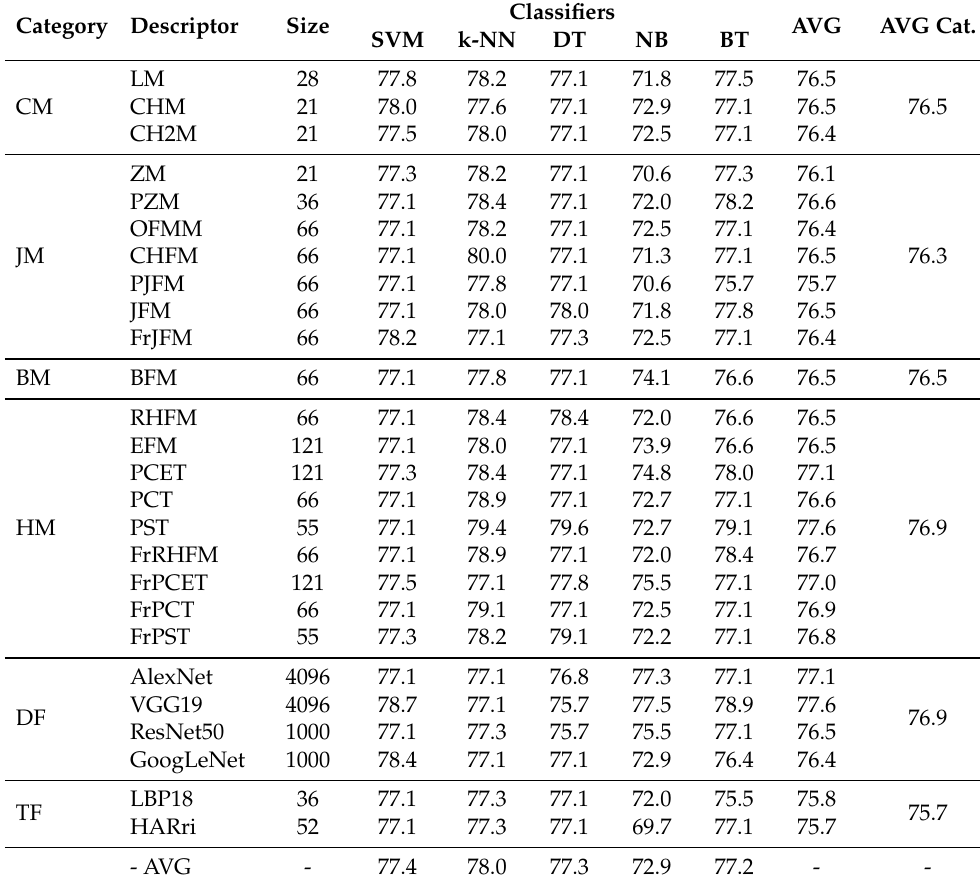
Table 5. Results obtained on the OASIS-MRI data set with all the analysed features, for which we report the categorisation (category column, CM—Cartesian moments, JM—Jacobian moments, BM— Bessel–Fourier moments, HM—harmonic moments, DF—deep features, and TF—texture features), the name (descriptor column), the feature size (size column), the accuracy obtained with all the tested classifiers (SVM, k-NN, DT, NB, BT columns) and the average accuracy value (AVG column). On the right (AVG cat.), we also report the average accuracy value of each category of features and on the bottom (AVG row), we report the average accuracy per